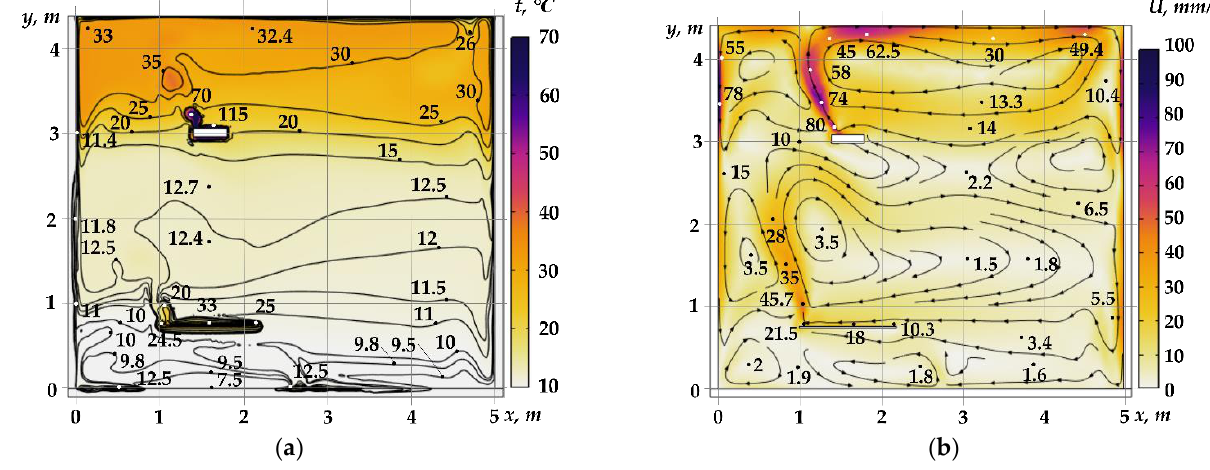
Figure 8. Temperature fields ( a ) and streamlines ( b ) for the area with the panel ( X Tb = 1.6 m, Y Tb = 0.755 m) in the GIH operation zone (τ = 60 min).